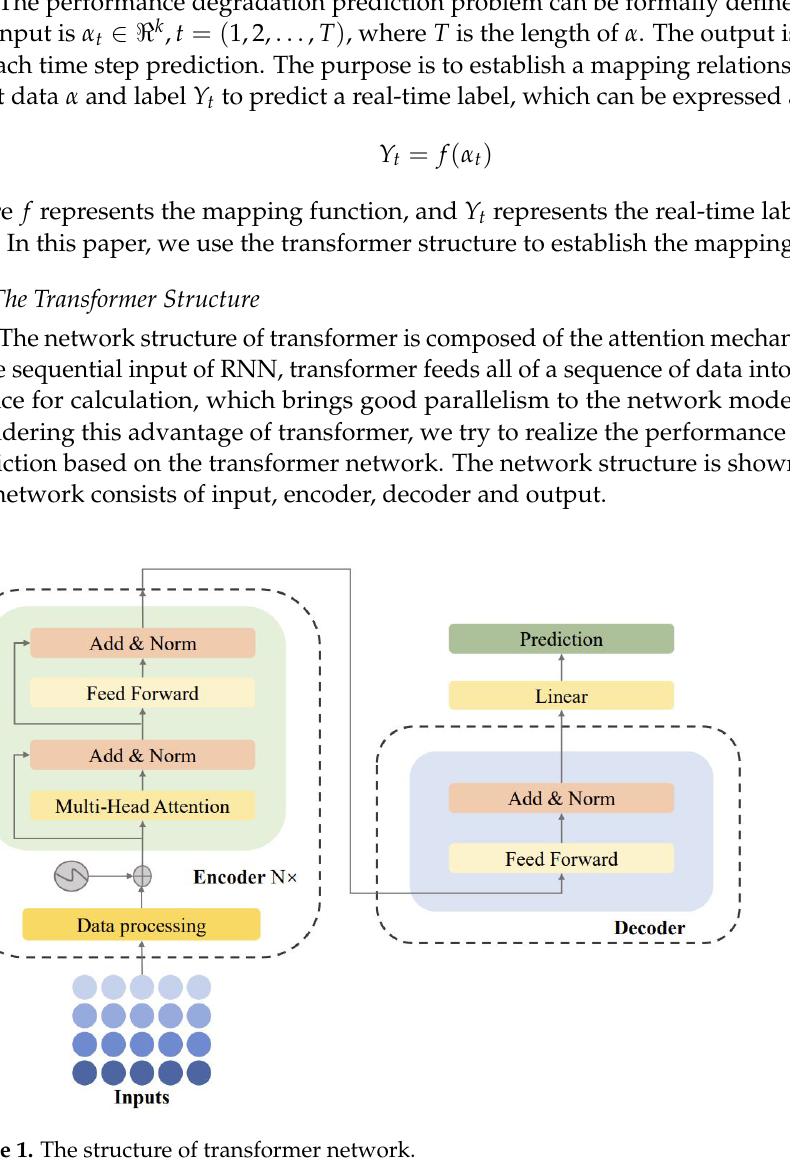
Figure 1. The structure of transformer